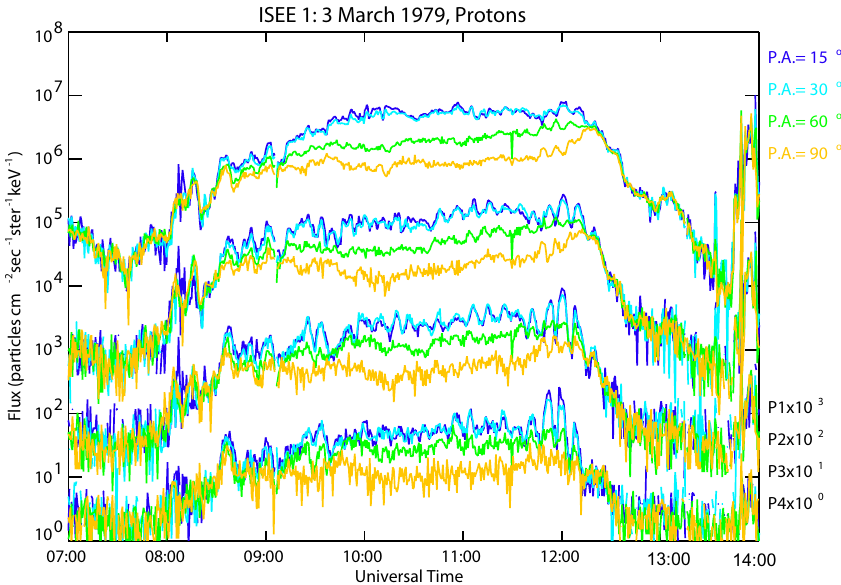
Fig. 6. Pitch angle flux distributions for protons in the energy channels P1 (24.0–44.5keV), P2 (44.5–65.3keV), P3 (65.3–95.5keV), P4 (95.5-142.0keV) recorded by ISEE-1. Pitch angles of 15 ◦ ± 5 ◦ , 30 ◦ ± 5 ◦ , 60 ◦ ± 5 ◦ , and 90 ◦ ± 5 ◦ are